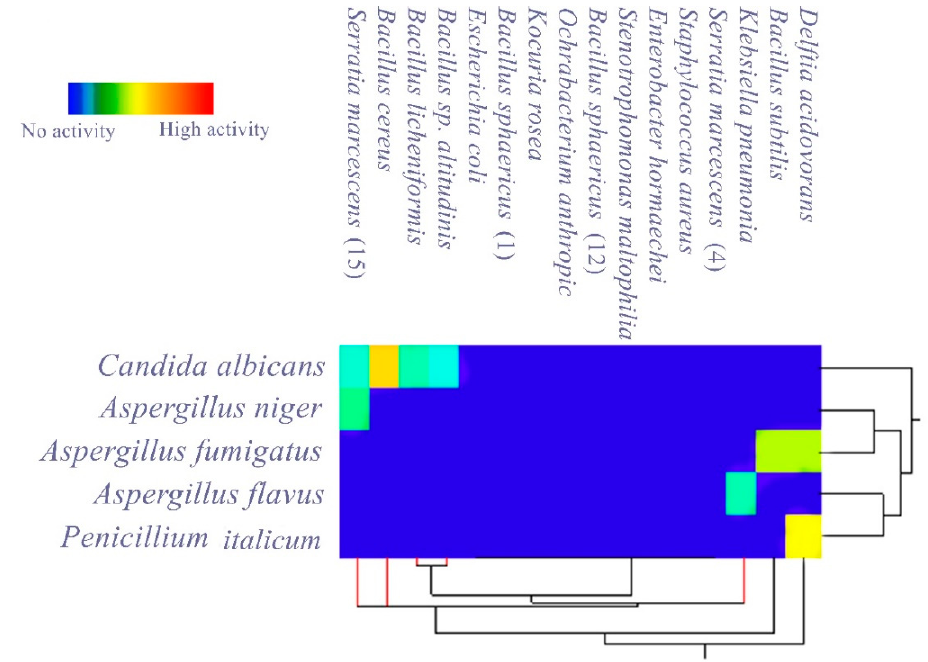
Figure 3. Matrix cluster analysis based on two-way single linkage Euclidian distance showing the level of antagonistic activity of bacterial symbionts isolated from P. americana L. against tested MDR pathogenic fungi.